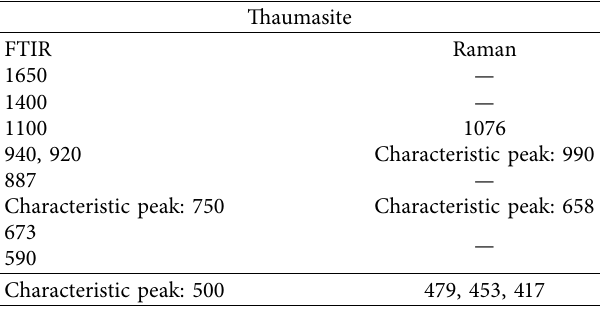
Table 4: The vibrational spectra and band assignment of thau- masite [21].